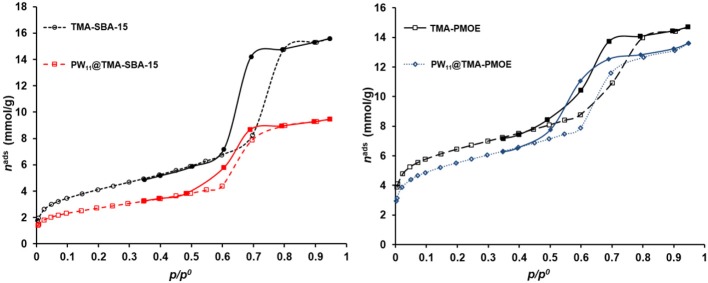
N2 adsorption-desorption isotherms of the TMA-SBA-15 and PW11@TMA-SBA-15 composite (left); TMA-PMOE and PW11@TMA-PMOE (right).